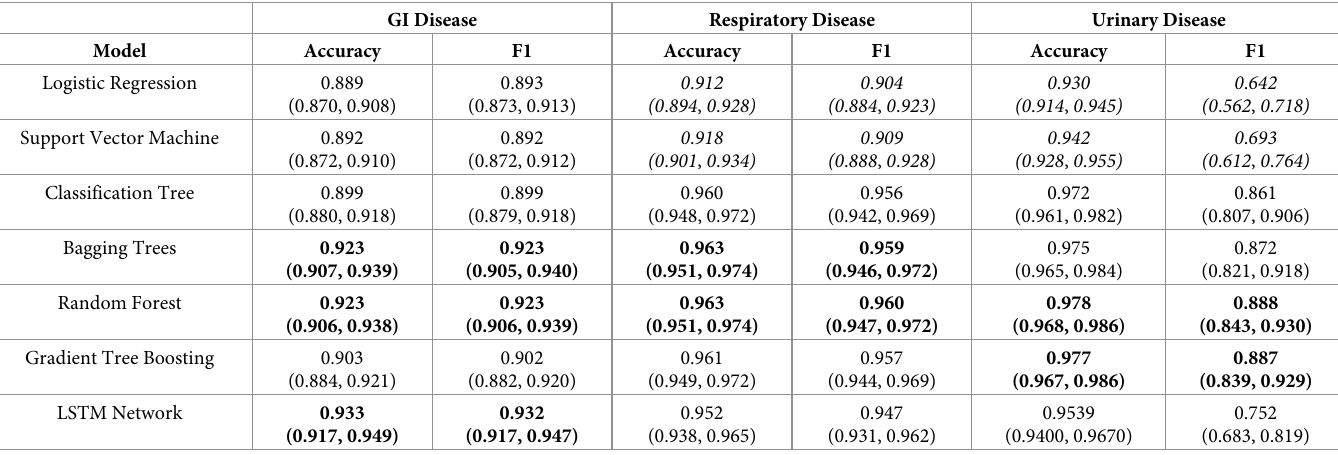
Table 3. Performance metrics for machine learning